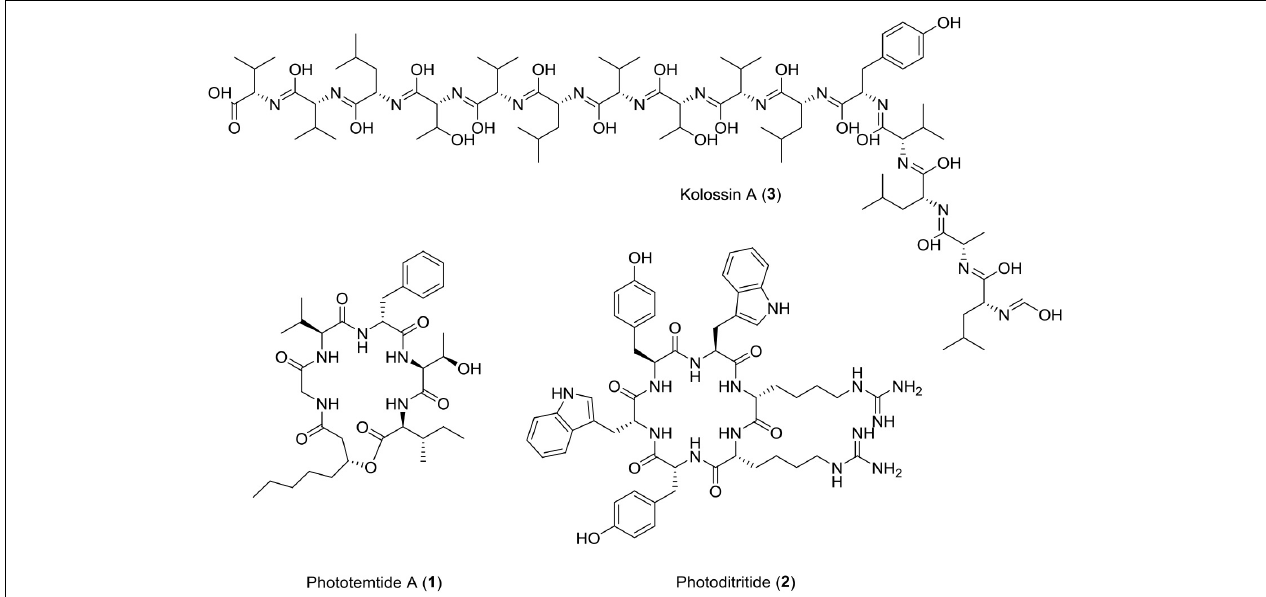
FIGURE 3 | Chemical structure of antiprotozoal compounds (1–3)